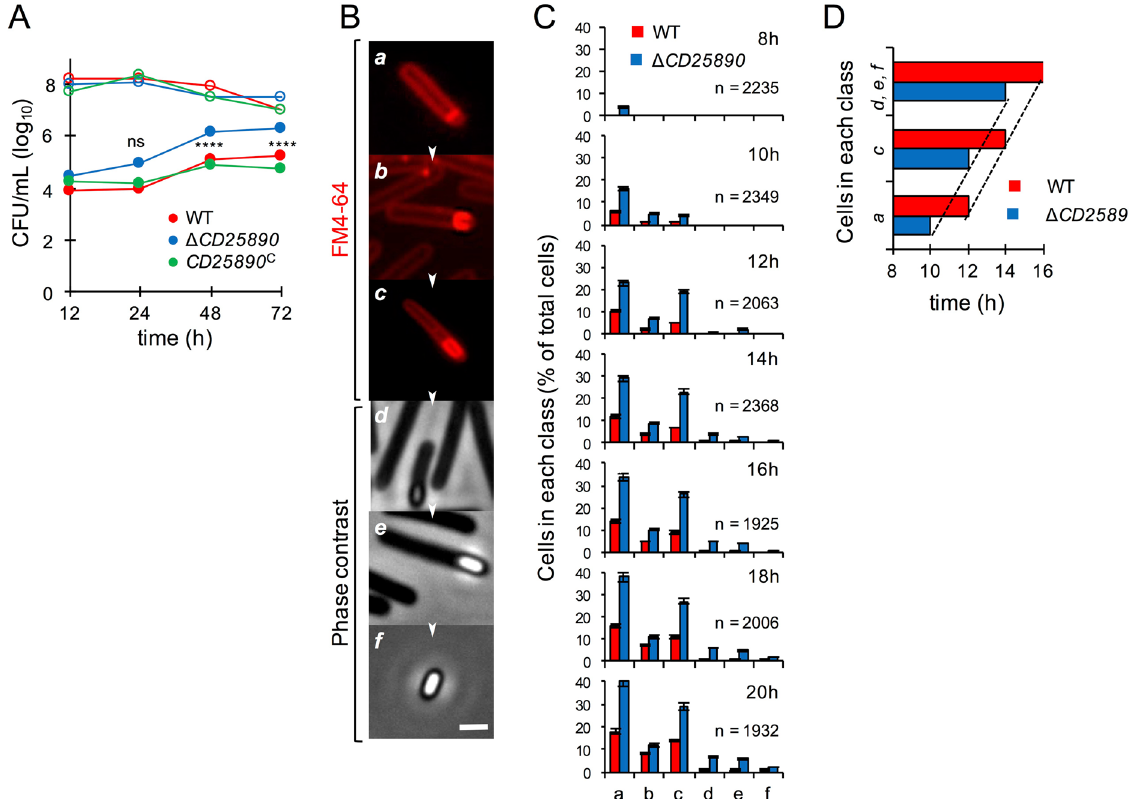
Figure 2. Analysis of (cid:31) CD25890 mutant sporulation dynamics. ( A ) Cells were grown in liquid SM and the titer of heat resistant spores (filled circles) and total viable cells (open circles) measured 12, 24, 48 and 72 h following inoculation. WT, red; (cid:31) CD25890 mutant, blue; CD25890 C (complementation strain), green. The date in the graph represent the mean of three independent experiments (see also Table S1). Asterisks indicate statistical significance determined with a two-way ANOVA (ns, no significant; **** p < 0.0001). ( B ) The panels (a-f) illustrate the sequence of the sporulation stages quantified in ( C ) the process begins with an asymmetric cell division ( a ), then, the mother cell membrane migrates around the forespore engulfing it (b). At the end of this process, the forespore becomes a free protoplast in the mother cell cytoplasm (c). Finally, the spore protective layers are synthesized and deposited around the developing spore (d and e). Upon mother cell lysis, a mature spore is released to the environment, where it remains in a dormant state until germination-promoting conditions are met (f). Images were acquired by Metamorph™ (version 5.8; Molecular Devices) ( C ) Samples of an SM liquid culture of the WT strain were collected at 8, 10, 12, 14, 16, 18 and 20 h after inoculation, stained with the membrane dye FM4-64 and examined by phase-contrast or fluorescent microscopy. Quantification of the percentage of cells in the morphological classes represented in B ( a to f ), relative to the total viable cell population, for the WT (red) and (cid:31) CD25890 mutant (blue) at the indicated times following inoculation in liquid SM. The data represent the mean ± SD of three independent experiments. The total number of cells scored (n) is indicated in each panel. ( D ) Time, in hours, when at least 10% of WT or (cid:31) CD25890 population reached the indicated stages of sporulation. The top columns show phase-bright, phase-grey spores or free spores (morphological classes d , e and f ), the middle columns engulfment completion ( c ), and the bottom columns asymmetric septation ( a